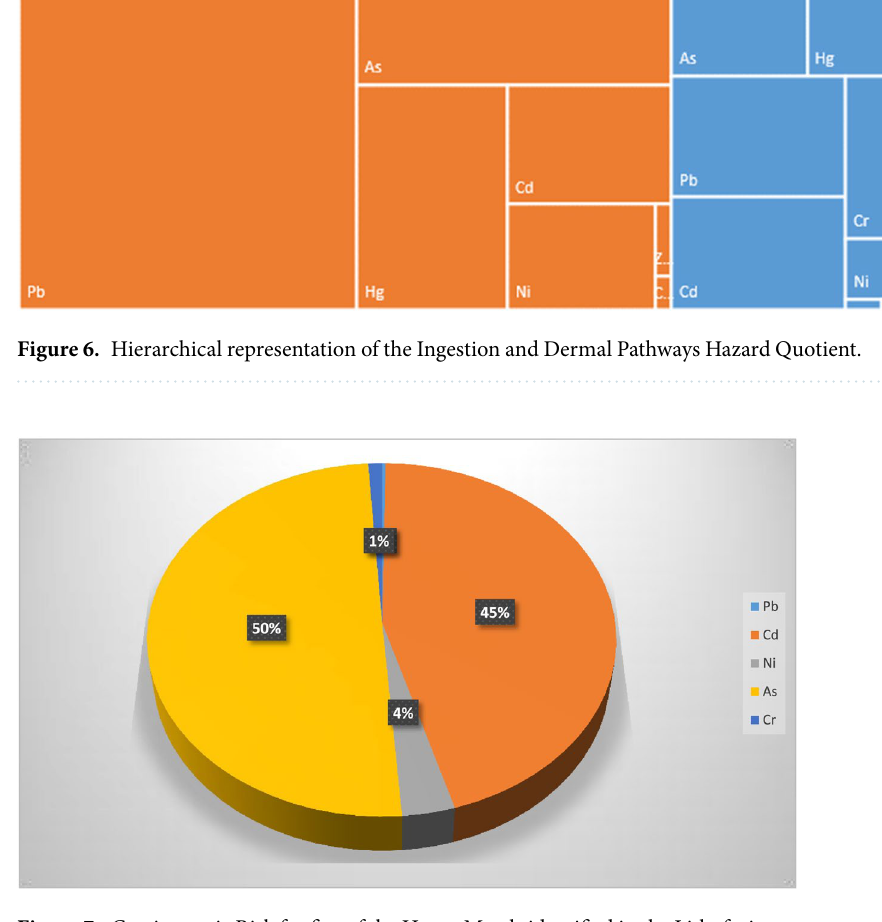
Figure 7. Carcinogenic Risk for five of the Heavy Metals identified in the